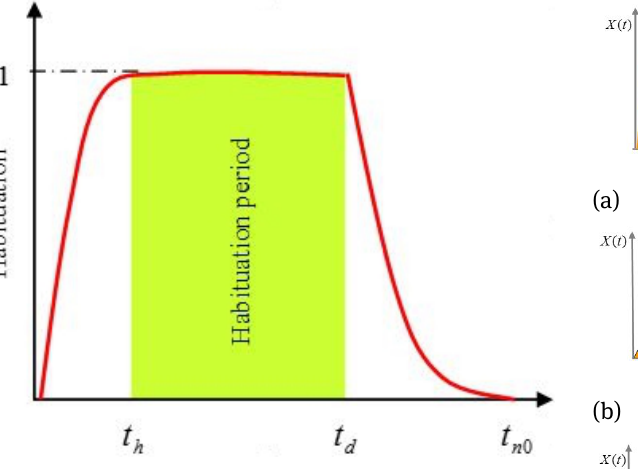
Figure 2: Habituation curve representing novelty over time.